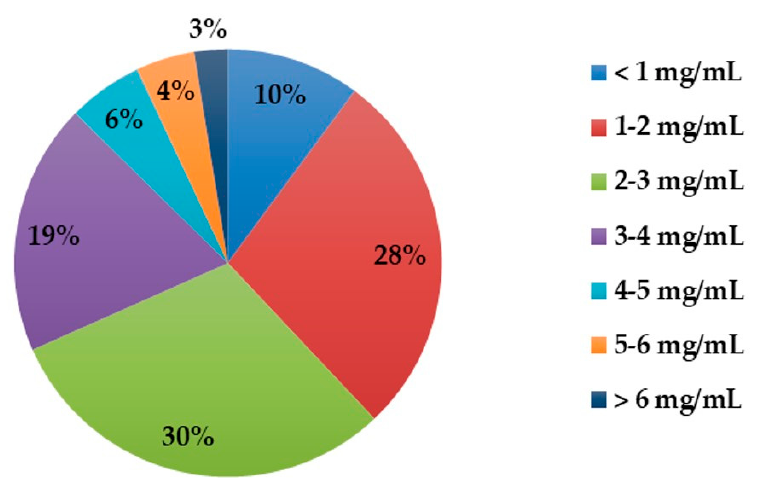
Figure 3. Levels of creatinine in 166 pig urine samples, determined with the LC-UV method.